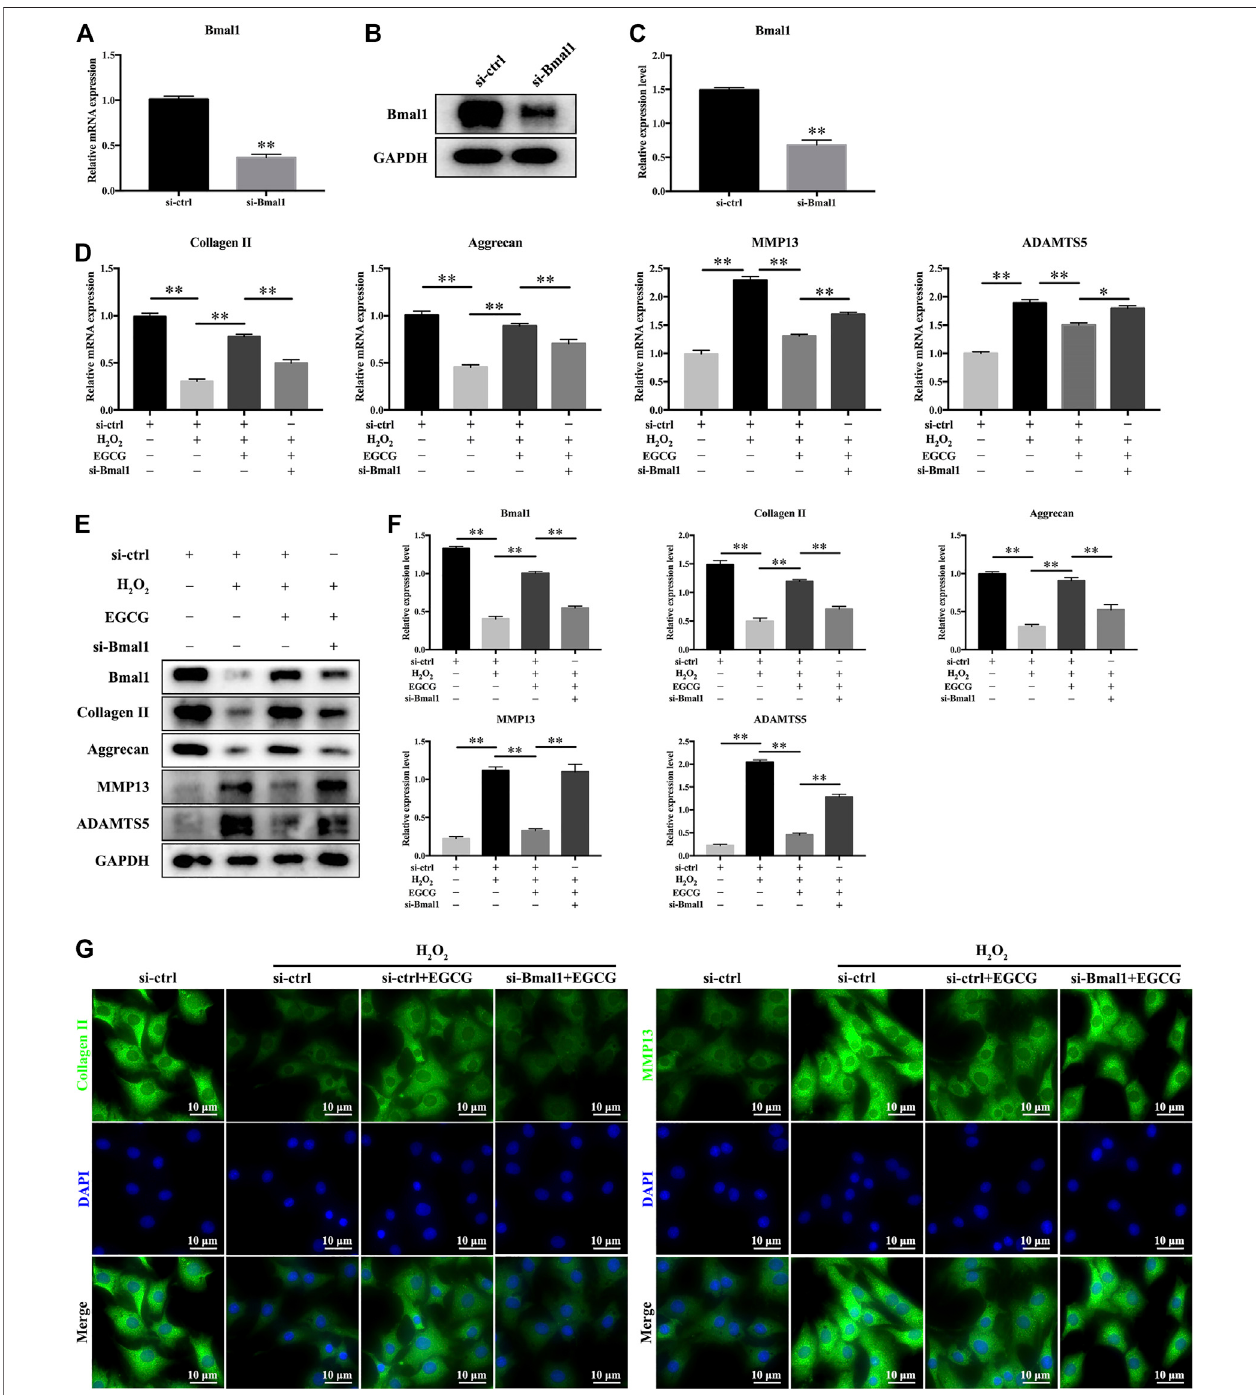
FIGURE 5 | Bmal1 is involved in EGCG-mediated prevention of ECM degradation in NPCs under oxidative stress conditions. Rat NPCs were transfected with si- Bmal1orsi-ctrlfor48 h,followedbypretreatmentwithorwithout20 μ MEGCG for4 handwithH 2 O 2 foranadditional24 h (A) mRNAand (B,C) protein levelsofBmal1. (D) mRNAlevelsofCollagenII,Aggrecan,MMP13,andADAMTS5. (E) TheexpressionlevelsofBmal1,CollagenII,Aggrecan,MMP13,andADAMTS5wereexaminedin rat NPCs using western blot. (F) Findings of densitometric analysis of the blots are shown. (G) Immuno fl uorescence of Collagen II and MMP13 in NPCs. Data are shown as mean ± SD ( n (cid:2) 3). * p < 0.05, ** p < 0.01.